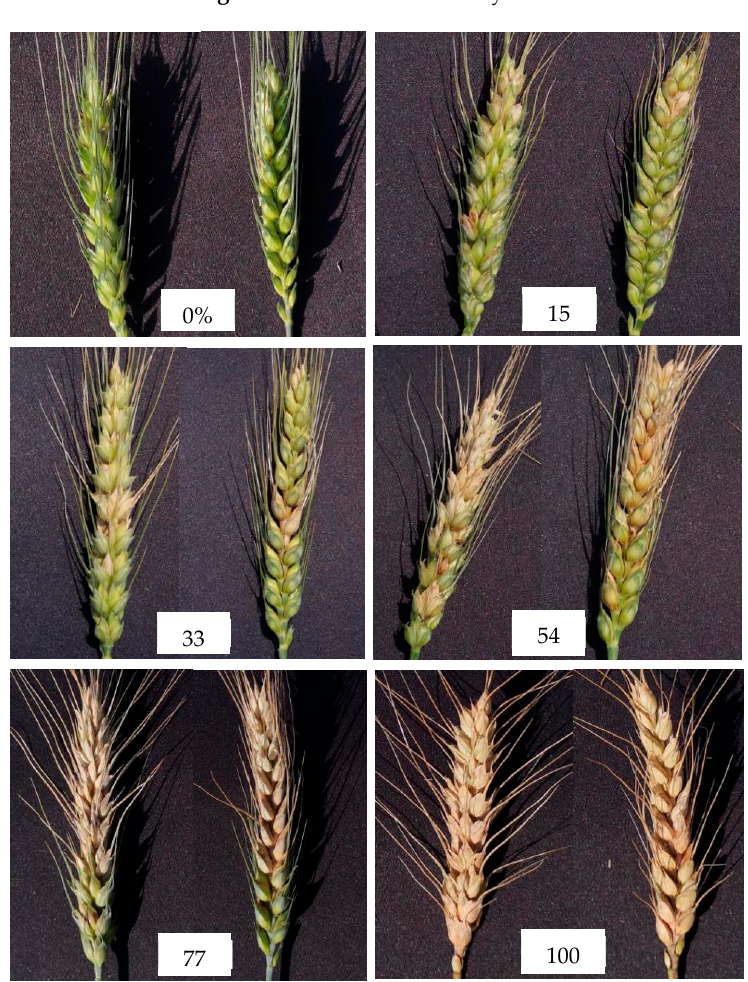
Figure 1. Location of the study area.